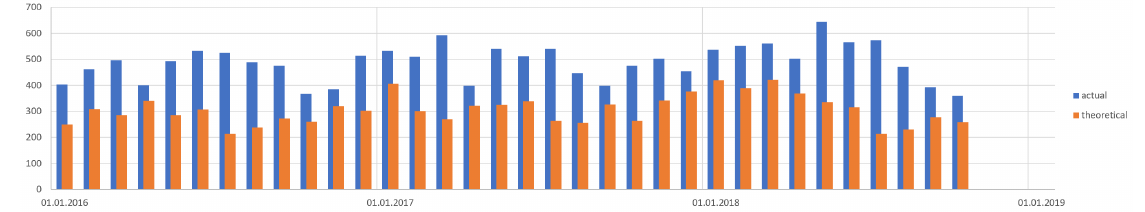
Figure 11. The comparison of the actual number of refuelings performed and the optimal (theoretical) number of refuelings.